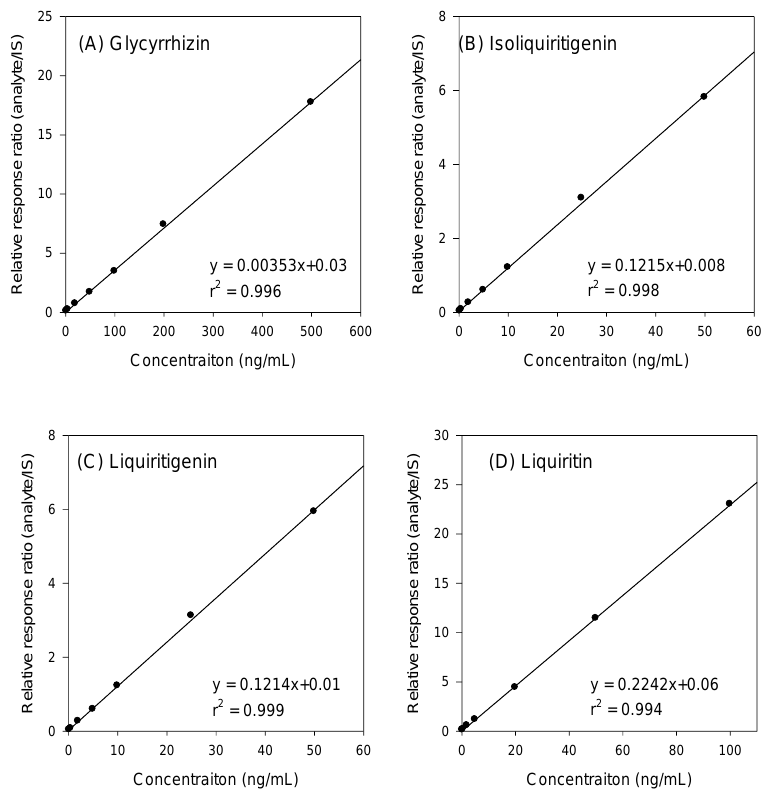
Figure 4. Representative calibration curves of ( A ) glycyrrhizin, ( B ) isoliquiritigenin, ( C ) liquiritigenin, and ( D ) liquiritin in rat plasma. Table 2. Linearity and LLOQs of glycyrrhizin, isoliquiritigenin, liquiritin and liquiritigenin. Analytes